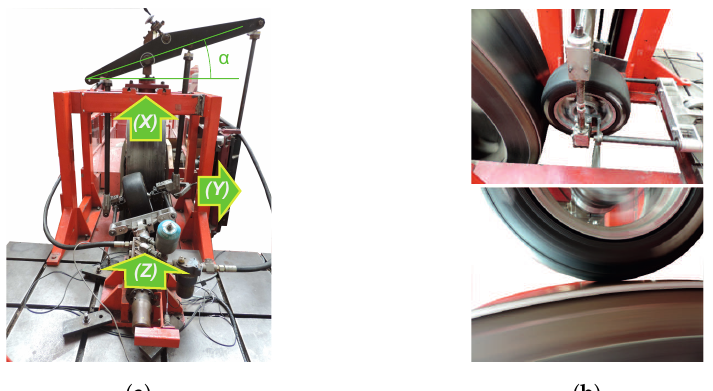
Figure 1. Test procedure applied to the intelligent tire: ( a ) The coordinate system used on the indoor tire test rig; ( b ) Instrumented tire set up on the tire test rig and its contact with the drum’s surface.